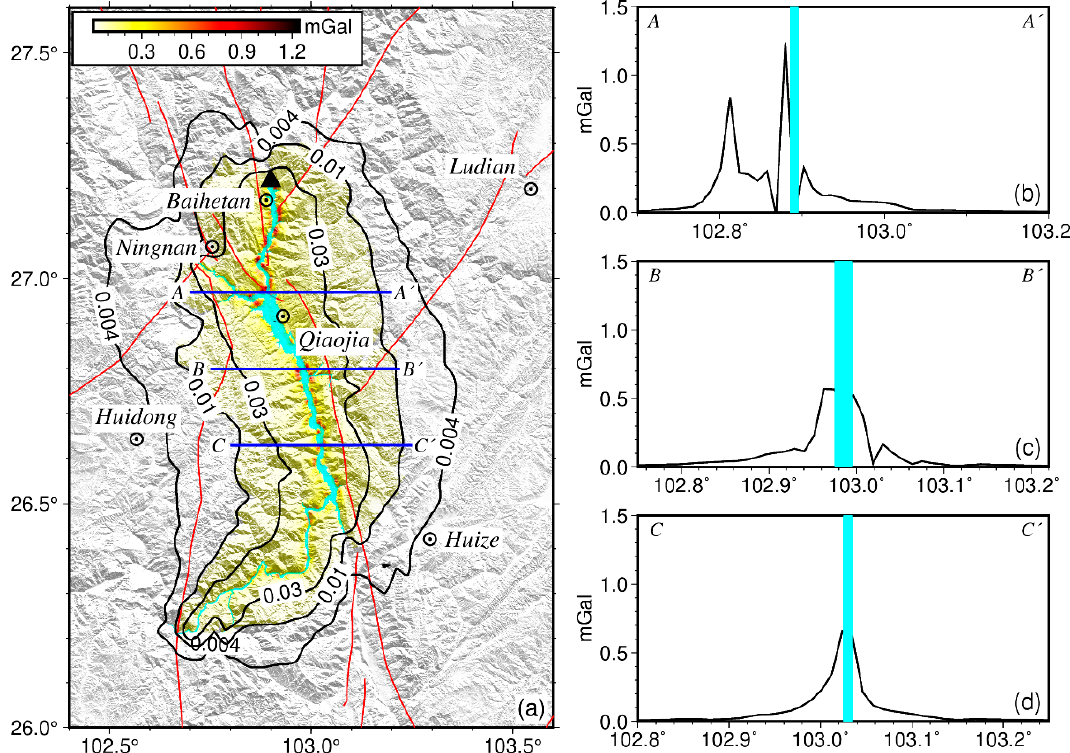
Figure 5. Bouguer Gravity Anomaly, crustal density structure and isostatic additional force (IAF) along the Baihetan reservoir. ( a ) Bouguer Gravity Anomaly and the Topography. ( b ) Density struc- ture. ( c ) IAF borne by the lithosphere. The light blue area in ( a , c ) indicate the main storage area where the reservoir is wide. The red dotted line denotes the zero line of IAF, and the black dotted line denotes the dam.